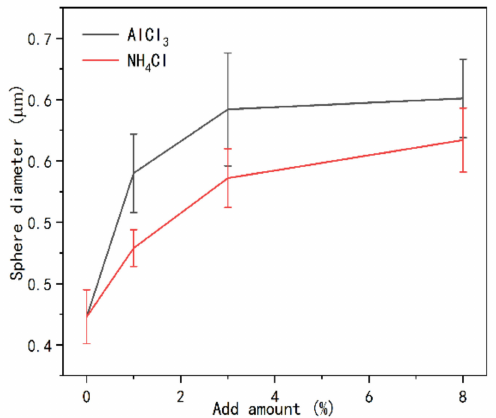
Figure 11. Comparison of the sphere diameters of UF resin with a molar ratio of 1.0 after curing under the influence of different addition amounts of NH 4 Cl and AlCl 3 .